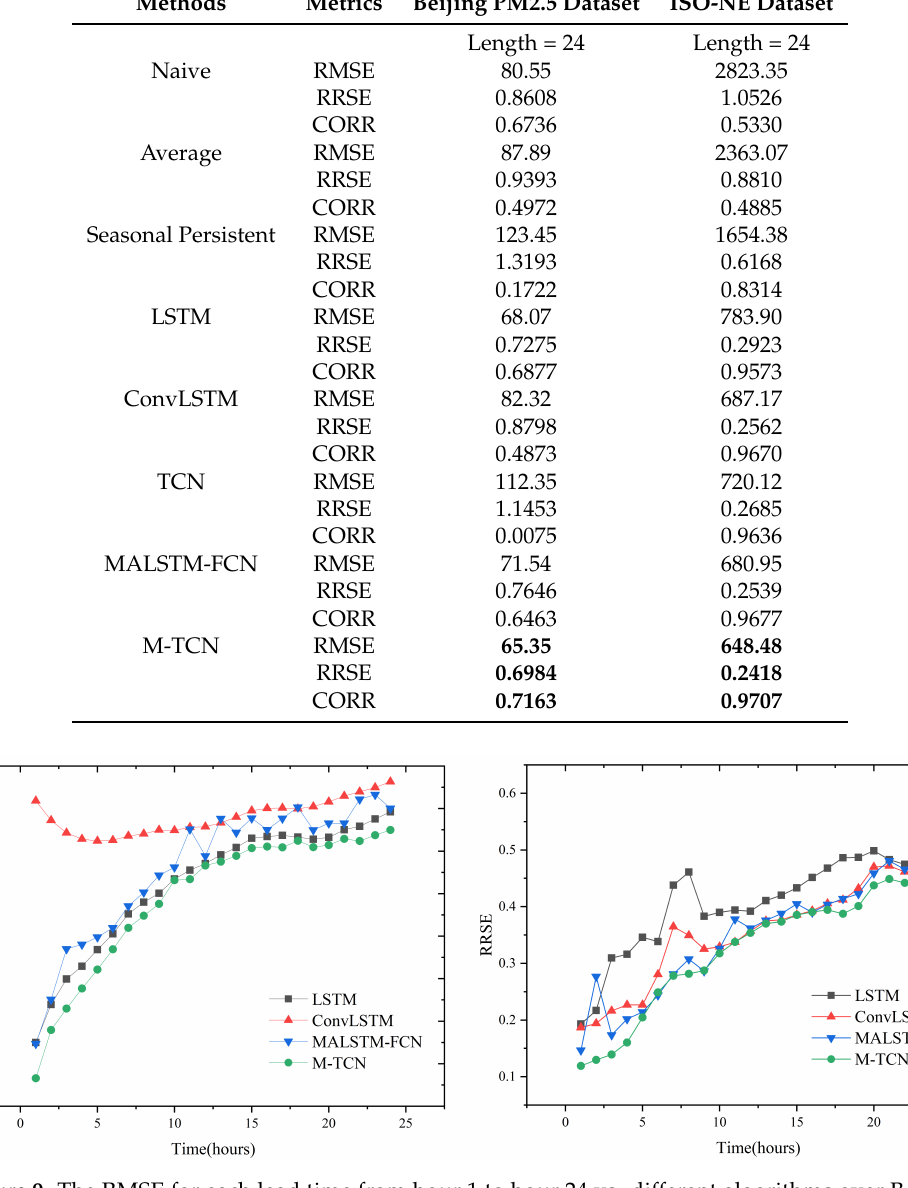
Table 4. Results summary (in RMSE, RSE and CORR) of all methods with two datasets.